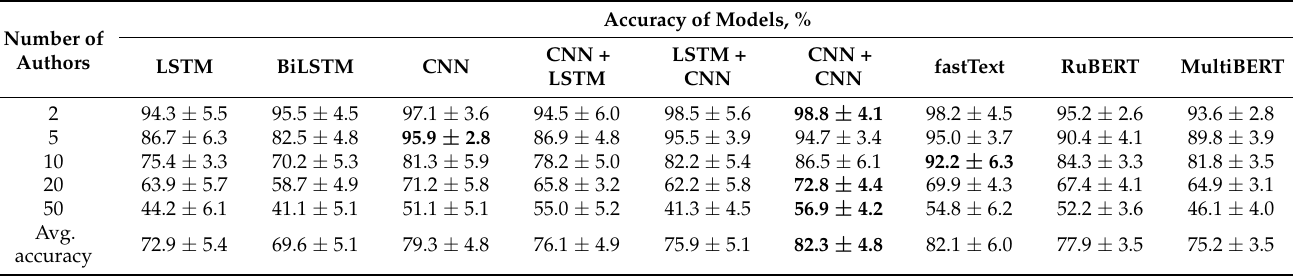
Table 5. Results of author identification using NNs.